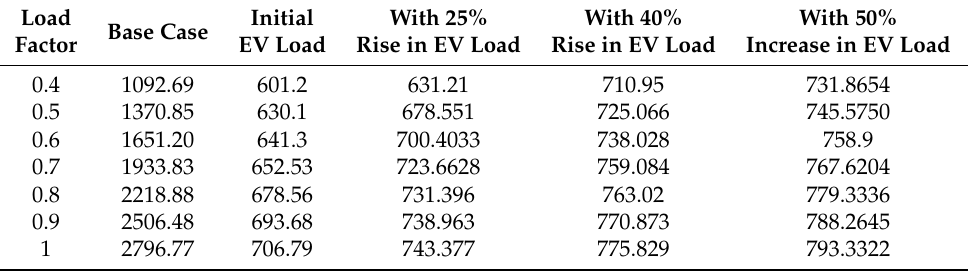
Table 15. Impact on the reactive power (kVAr) consumed from SS in the 69-bus radial DST.